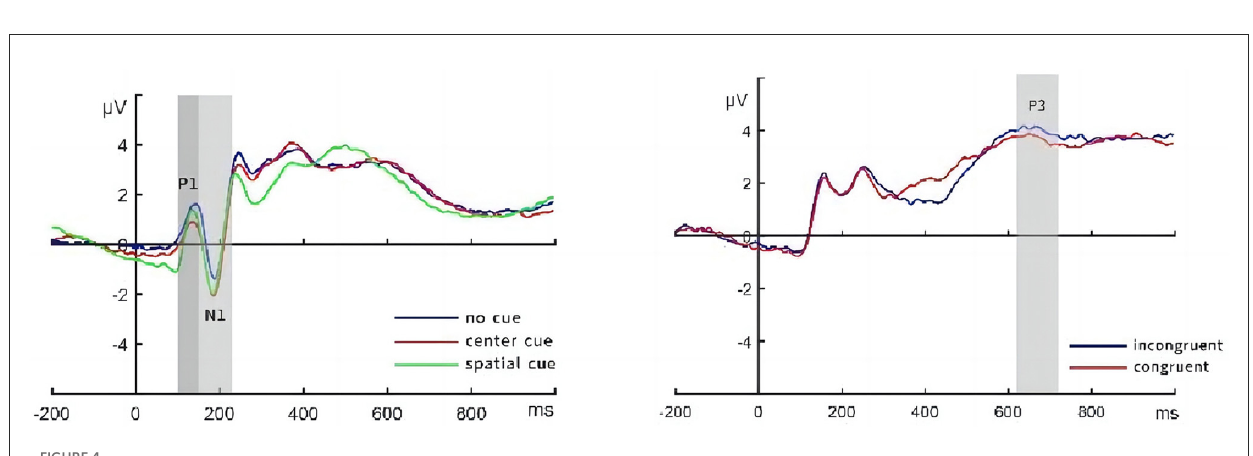
FIGURE4 Time window and frequency band for time-frequency